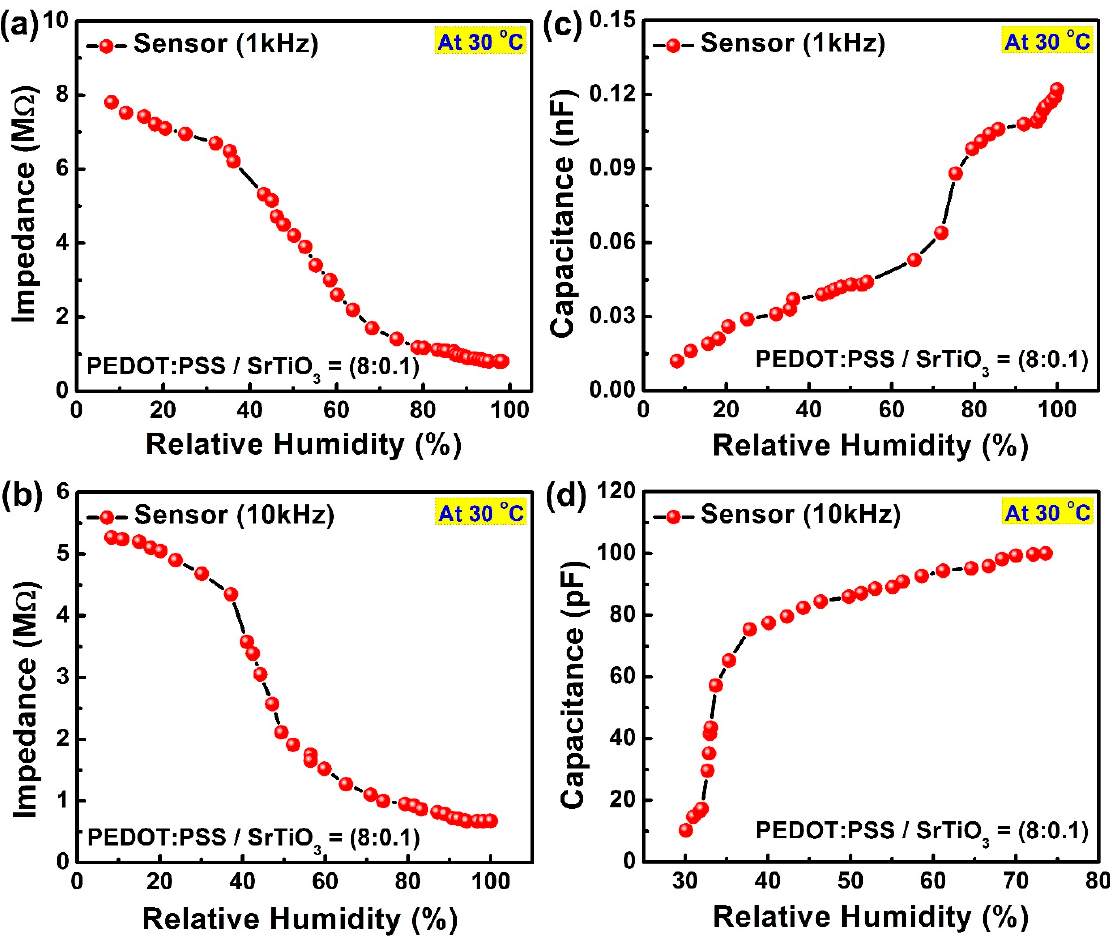
Figure 5. Electrical response of the sensor: ( a ) impedance versus relative humidity at 1 kHz; ( b ) impedance versus relative humidity at 10 kHz; ( c ) capacitance versus relative humidity at 1 kHz; ( d ) capacitance versus relative humidity at 10 kHz.